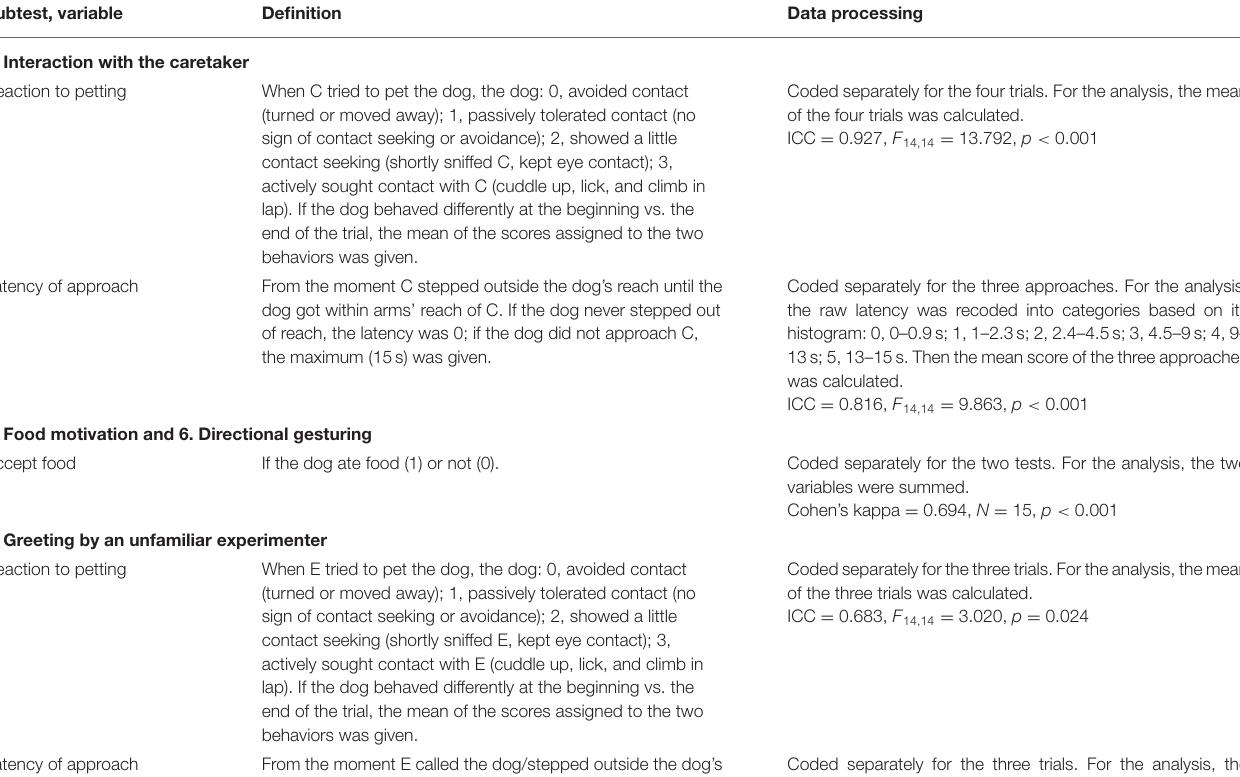
TABLE 1 | Definition of the variables coded in the tests and their inter-observer reliability [Cohen’s kappa or intraclass correlation (ICC)]. Subtest,